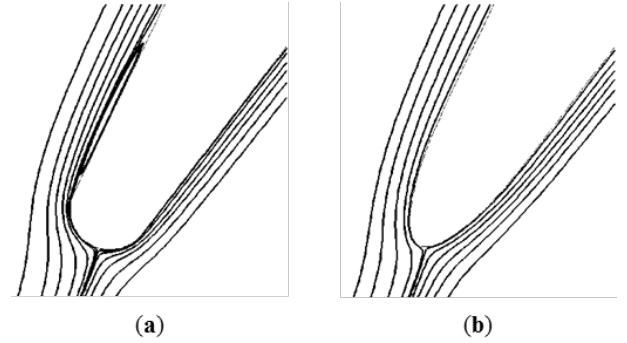
Figure 26. Time-averaged streamlines at mid-span (Re = 10 5 ): ( a ) circular LE; ( b ) continuous-curvature